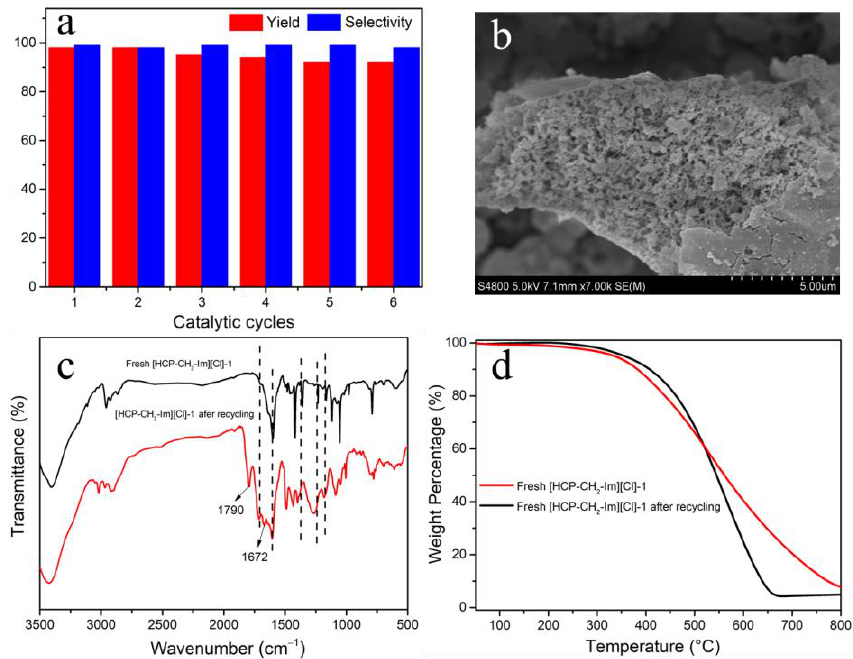
Figure 8. ( a ) Reusability of [HCP-CH 2 -Im][Cl]-1 for CO 2 cycloaddition with epichlorohydrin. Reaction conditions: styrene oxide (5 mmol), CO 2 (0.1 MPa), catalyst (25 wt%), 140 °C, 5 h, ( b ) SEM image, ( c ) FT-IR spectrum, ( d ) TG curves of [HCP-CH 2 -Im][Cl]-1 after having been run 6 times.